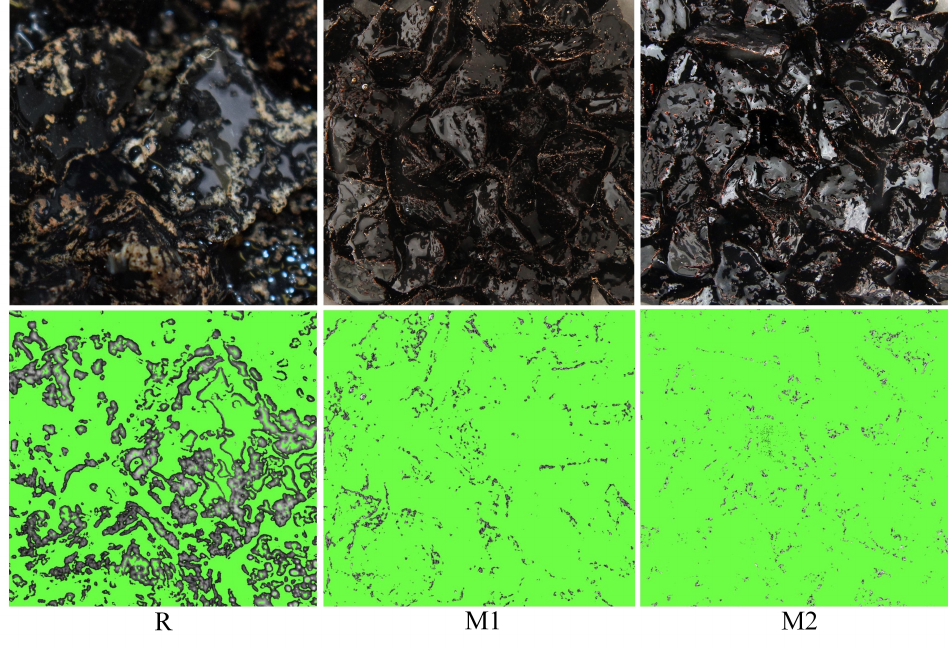
Figure 4. Images of aggregate coated by binder (top) and highlighted coated areas as a result form DIC analysis